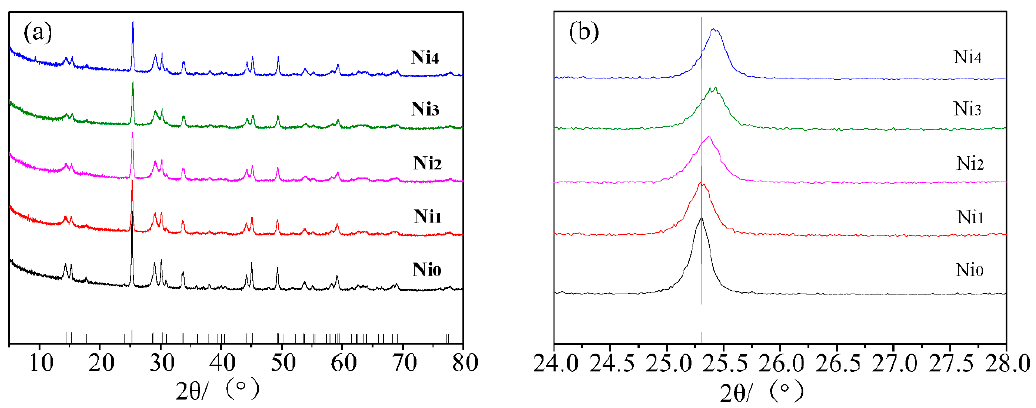
Figure 1. ( a ) XRD patterns of the Ni 0 , Ni 1 , Ni 2 , Ni 3 , and Ni 4 samples. ( b ) Local magnified XRD patterns from 24° to 28°.